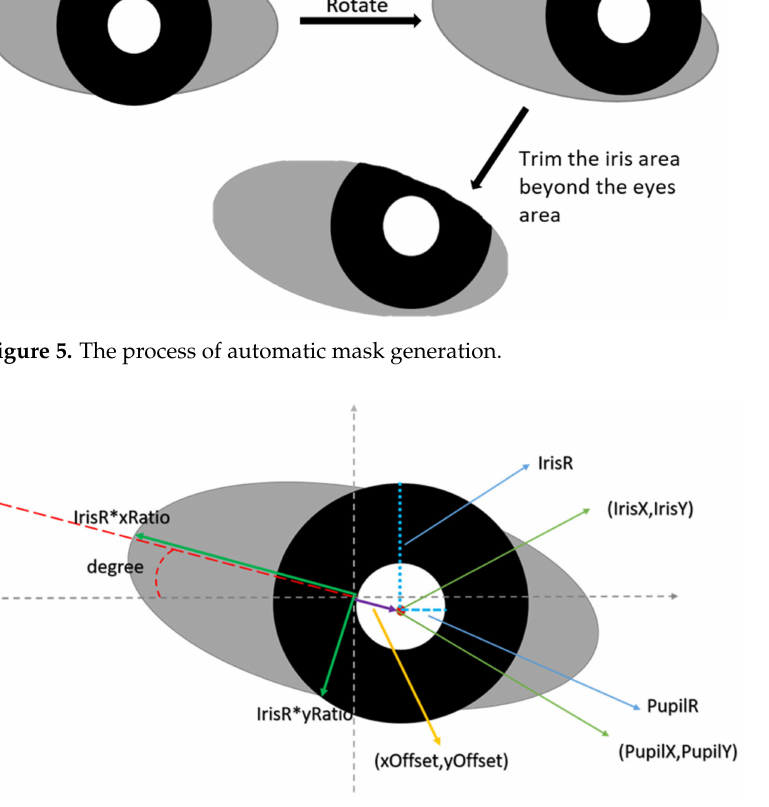
Figure 6. A pictorial explanation to determine the 11 parameters to generate the masks. Table 1. The statistics of the 11 parameters used for generating the iris mask and periocular